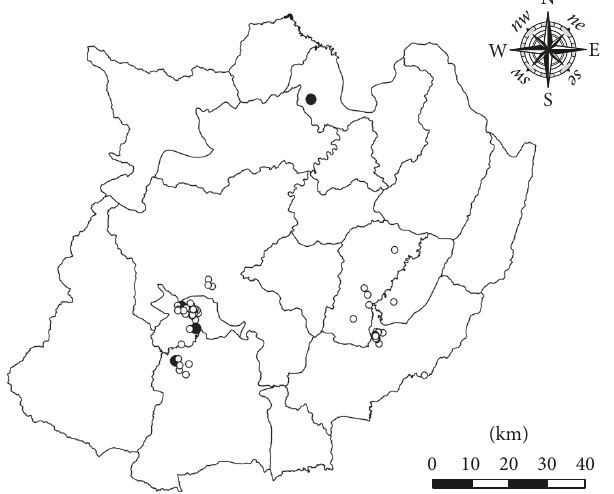
Figure 3: Locations of case- and control-farms in Chiang Rai province during 2011–2015. Black dots indicate case-farms and white dots indicate